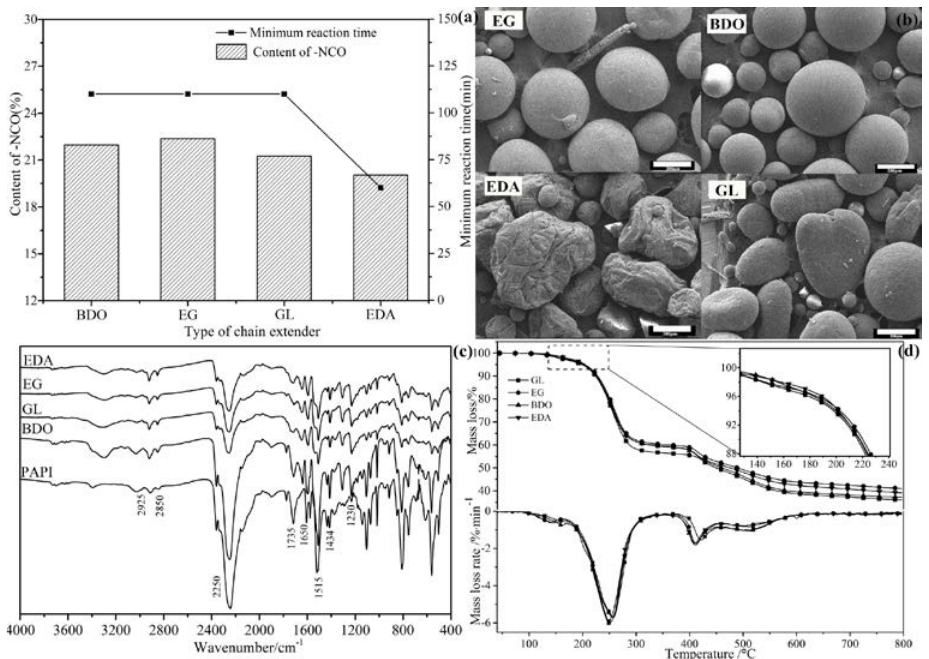
Figure 5. The minimum reaction time with different type of chain extender ( a ), morphology of microcapsules ( b ), Fourier transform infrared (FTIR) spectra ( c ) and thermogravimetric analysis (TGA) mass loss and its derivatives curves ( d ) of microcapsules obtained at various type of chain extender.